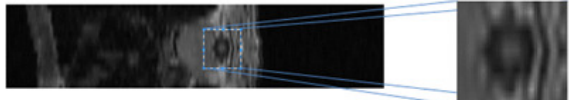
Figure 6. Transverse view of an image T1. Source: Hospital